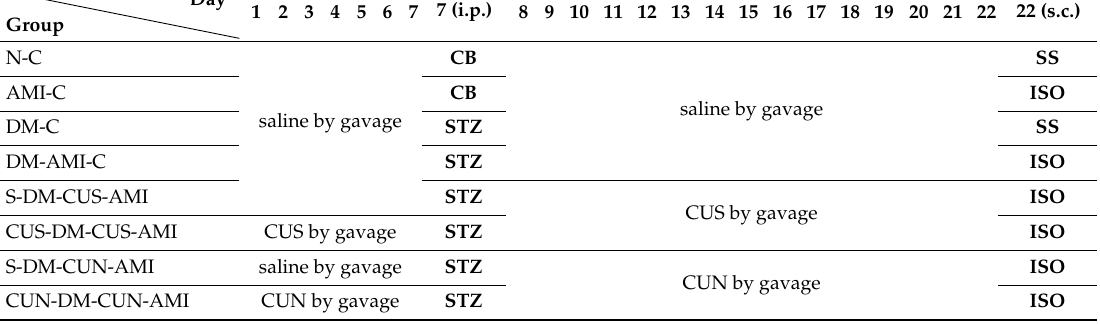
Table 1. Design of the experimental study